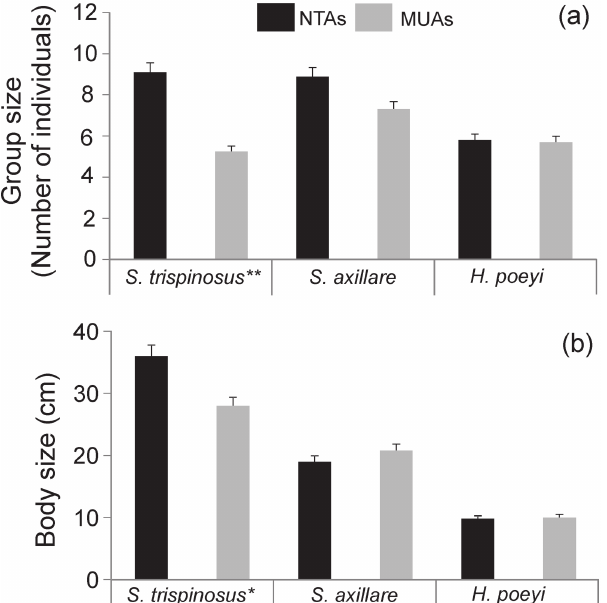
Fig. 5. Average group size (a) and body size (b) estimated for the three labrids studied in both no-takes (NTAs) and multiple-use areas (MUAs) sampled in the Abrolhos Bank. The upper limits of lines indicate standard error.